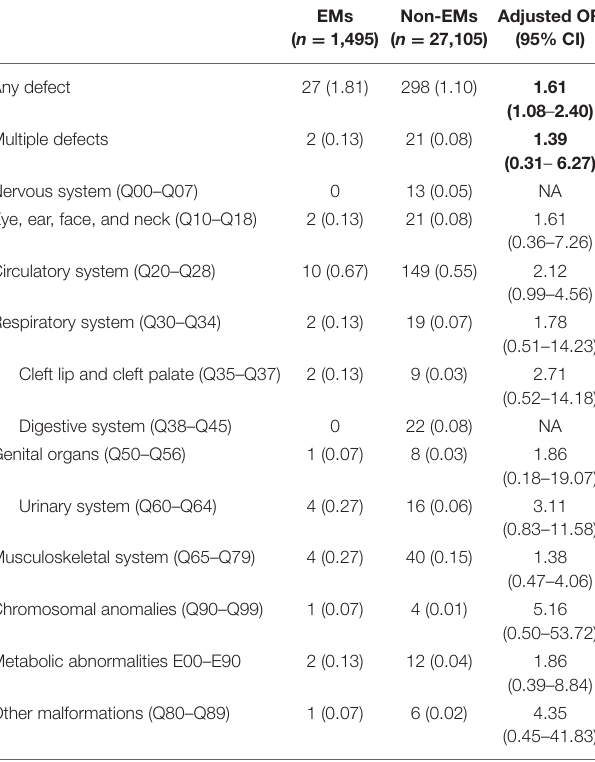
TABLE 1 | Maternal background characteristics and neonatal outcomes. TABLE 2 | Types of malformations among live-born infants.